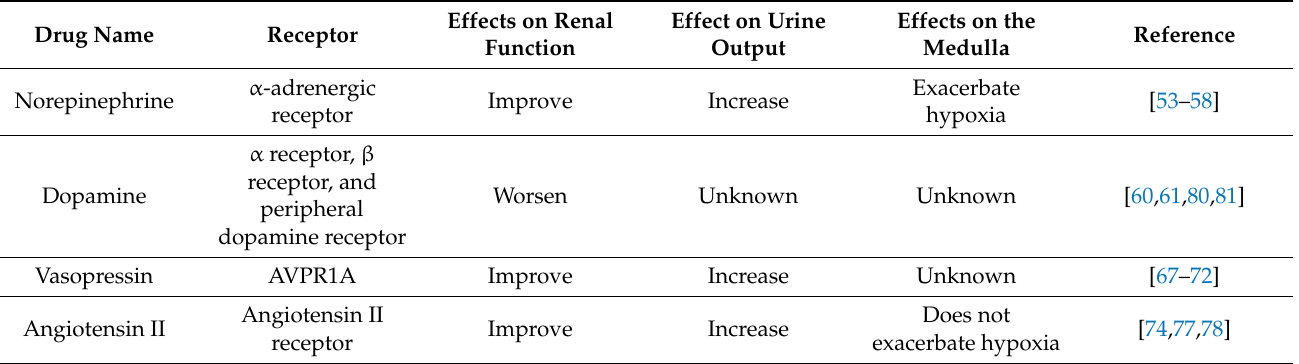
Table 1. Pharmacological effects and renal effects of the